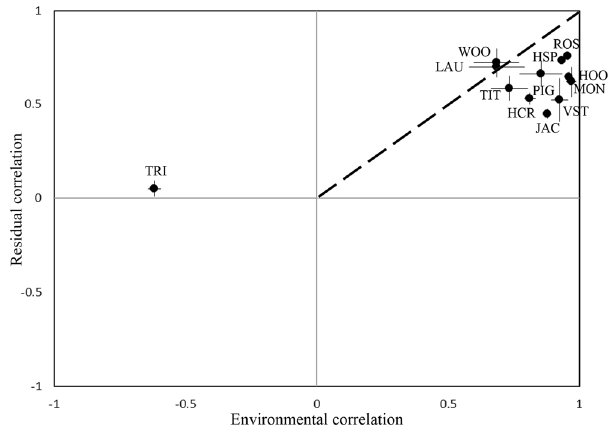
Figure 2. Modelled residual correlation and environmental correlation between common mynas and local species. Error bars represent standard deviation. Species abbreviations are detailed in Supplementary Table S2. Strong positive residual correlation suggests biological interactions between species, whereas that environmental correlation could indicate similar habitat preference. Dashed line represents a 1:1 trendline.